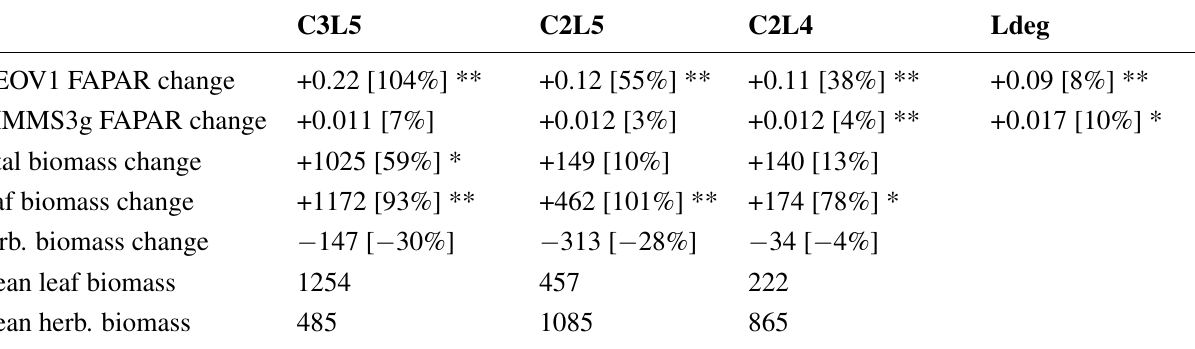
Table 2. The first four rows show vegetation change derived from linear regression for sites around Lingu`ere (Senegal) for the period 1987–2010. ** = significant at 95%; * = significant at 90% confidence level. Units are FAPAR and DM kg/ha. The change is calculated as the slope of annual values and multiplied by the number of years. It is further divided by the long-term mean to derive change in percent, shown in brackets. Note that a relationship between GEOV1 FAPAR and biomass trends is present and that FAPAR change increases with mean leaf biomass present. C3L5 C2L5 C2L4 Ldeg